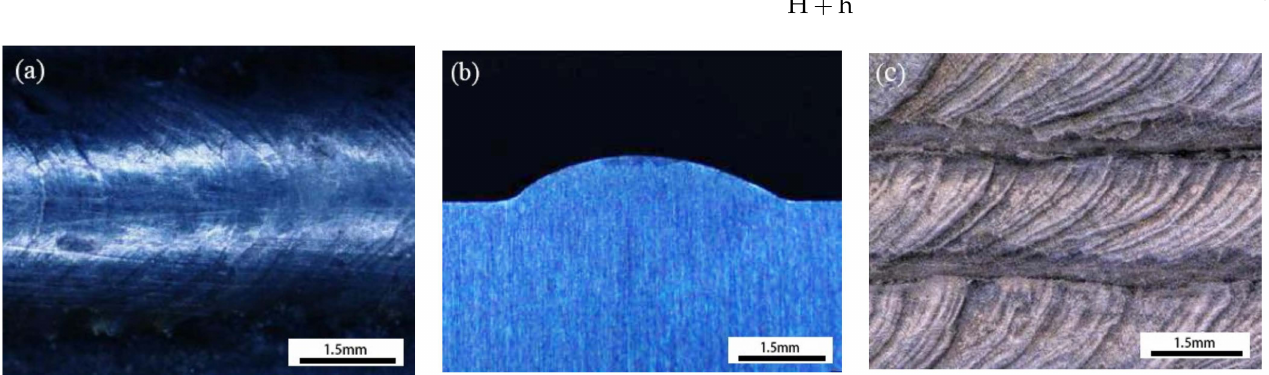
Figure 3. Macro morphology of cladding layer. ( a ) Single-channel surface, ( b ) Single-channel cross section, ( c ) Overlapping